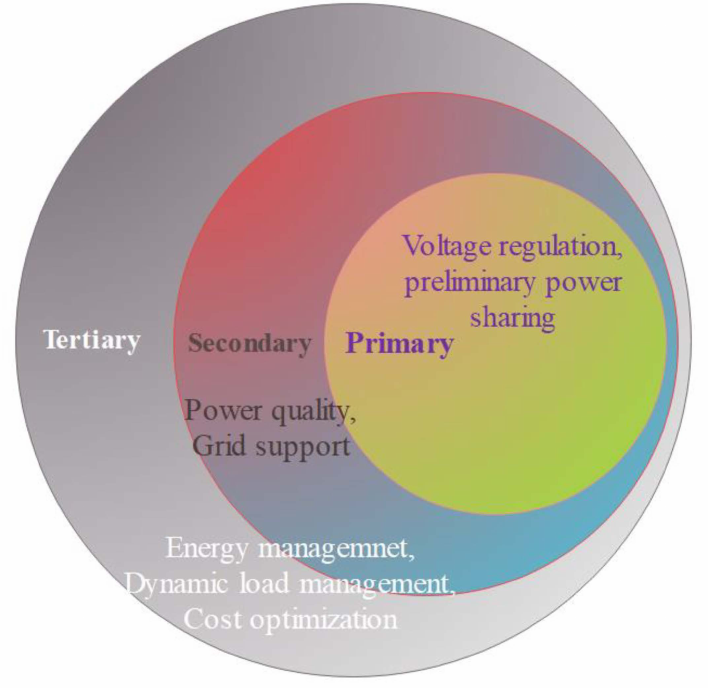
Figure 10. Classification of hierarchical control in an HMG. (Note: size of the circle shows the response time of the